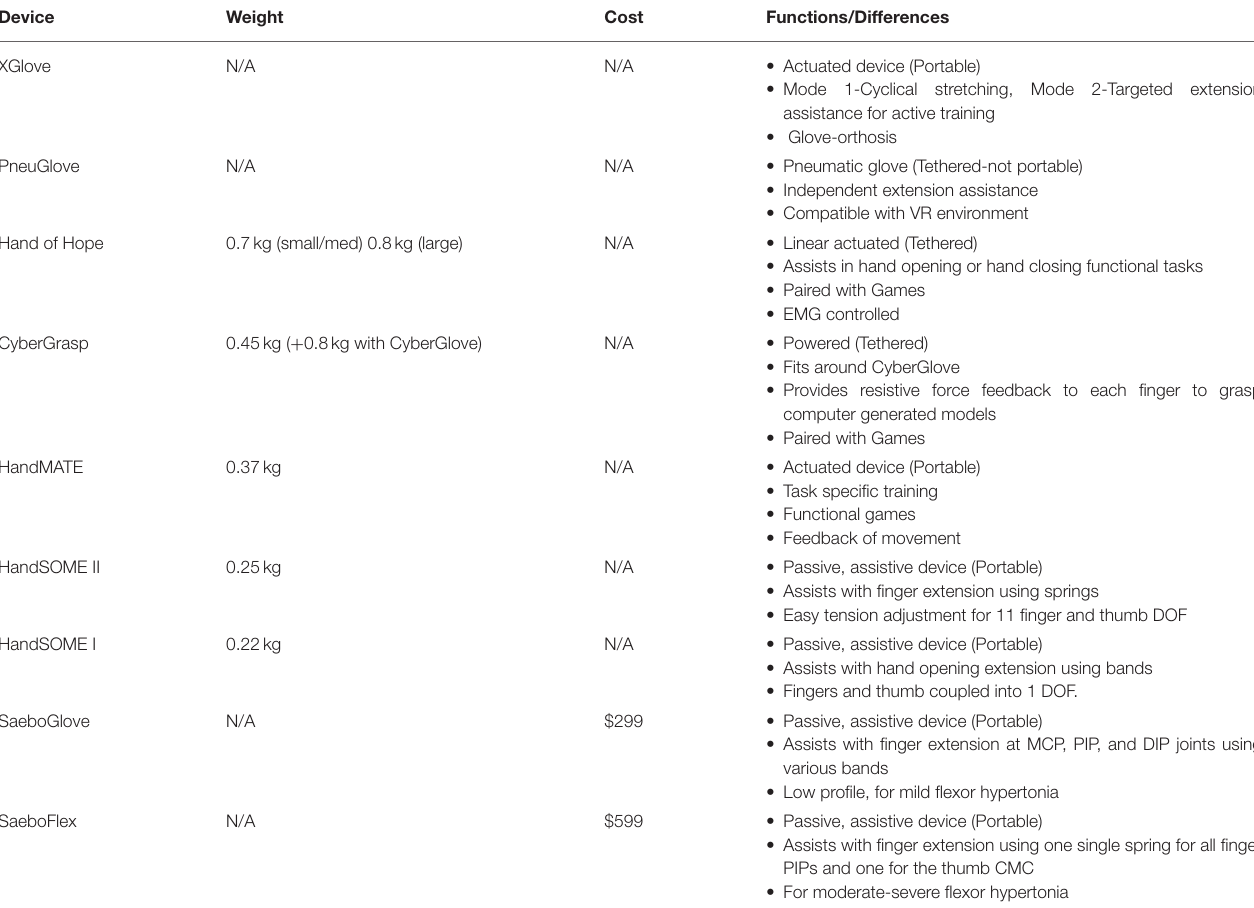
TABLE 1 | Comparison of exoskeletons for hand rehabilitation. Device Weight Cost